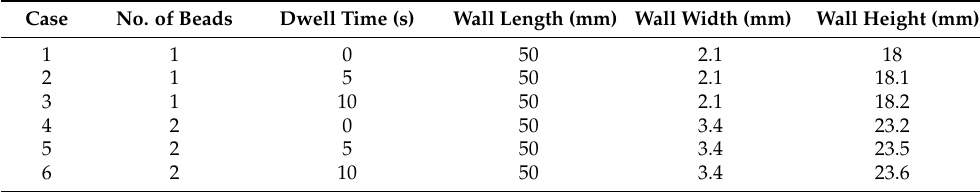
Table 2. Description of the experiment cases with process parameters.